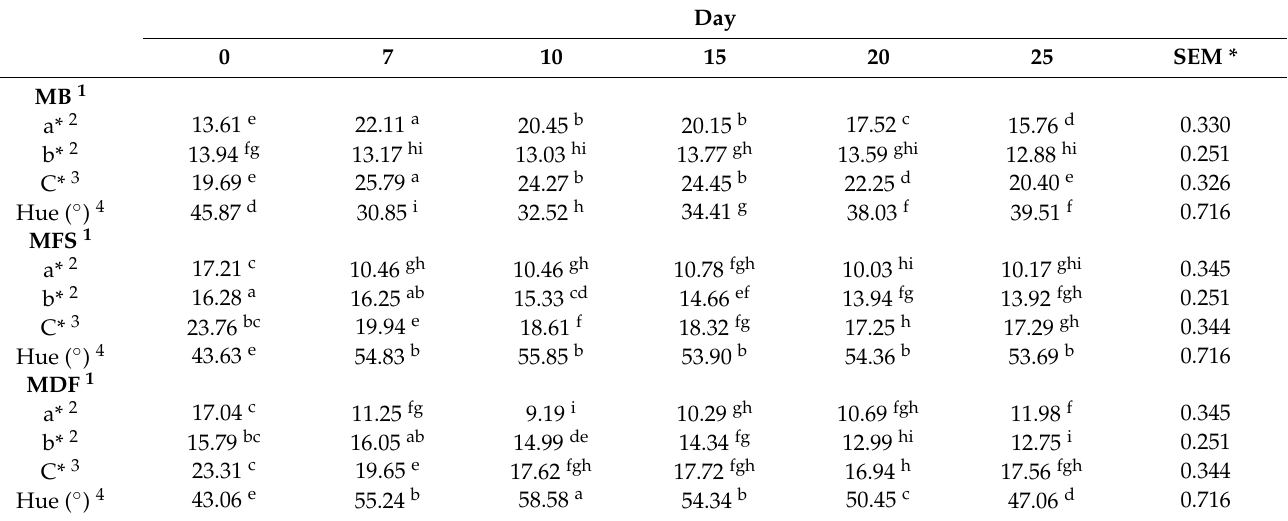
Table 1. Interactive impact of packaging method × day of display on instrumental color